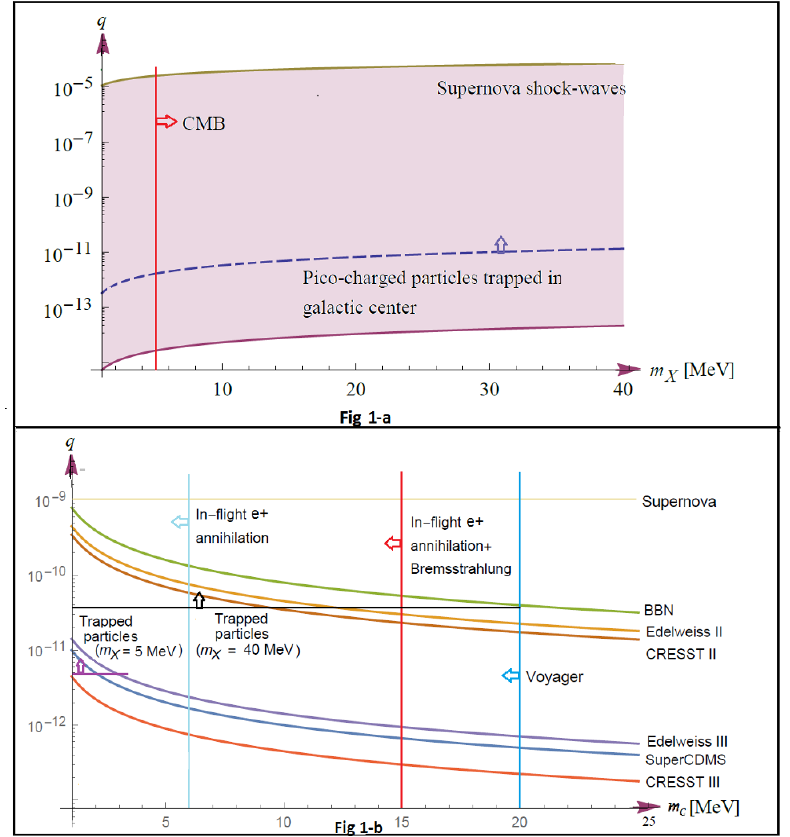
Figure 1 . (a) (upper panel) : electric charge of C particles versus dark matter mass, m X , which is equal to twice the energy of C particles at production in the galaxy: E C = m X = 2. Blue dashed curve shows lower limit above which the C particles with energy m X = 2 stay in magnetic (cid:12)eld of 10 (cid:22) G with Larmour radius below 100 pc. Red vertical line indicates CMB lower bound on dark matter mass [5]. Shaded area shows the range of q for which energy pump by supernova shock-waves in the galaxy is e(cid:14)cient. (b) (lower panel) : bounds on the charge of C particle versus its mass. Line marked with supernova comes from supernova cooling [19]. Curve marked with BBN comes from imposing (cid:1) N e(cid:11) < 0 : 7 at the BBN era. Current bounds from Edelweiss II [35] and CRESST II